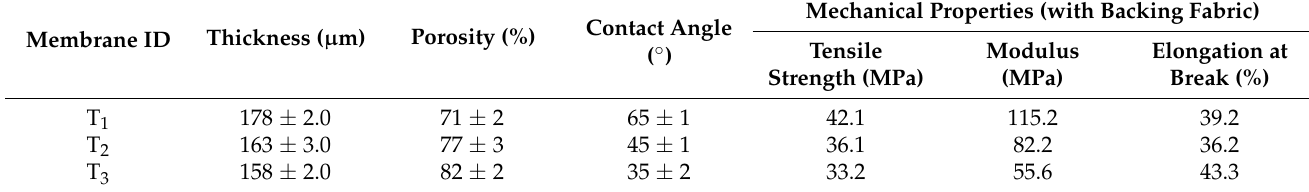
Table 3. Characterization of the membrane substrates with different degrees of sulfonation.